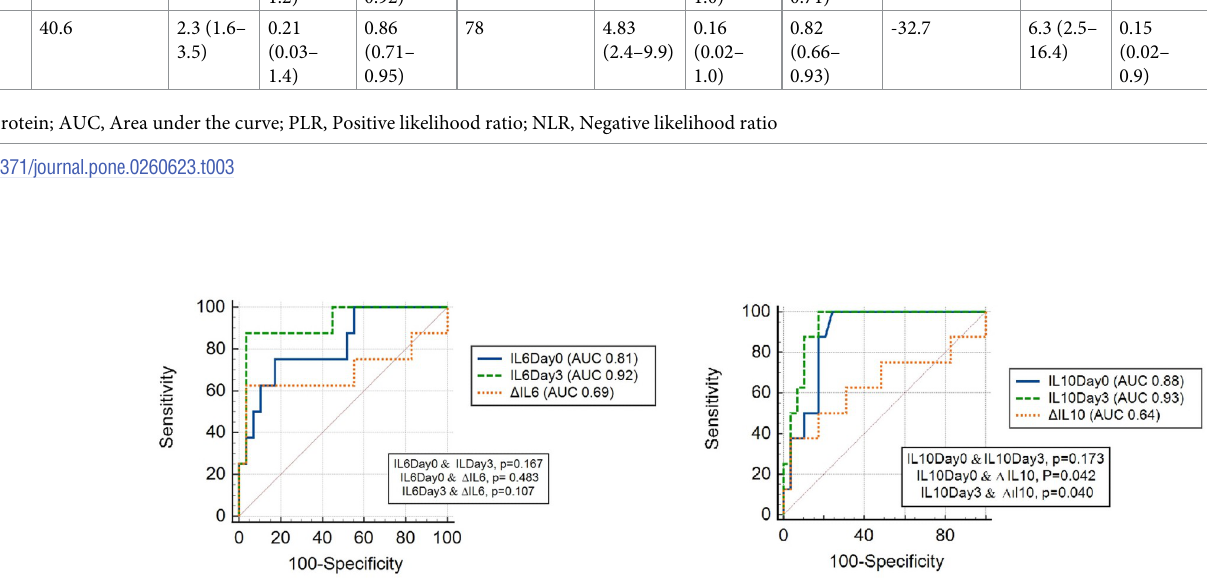
Fig 2. Comparison of ROC curves in predicting COVID-19-related mortality for serum IL-6 and IL-10